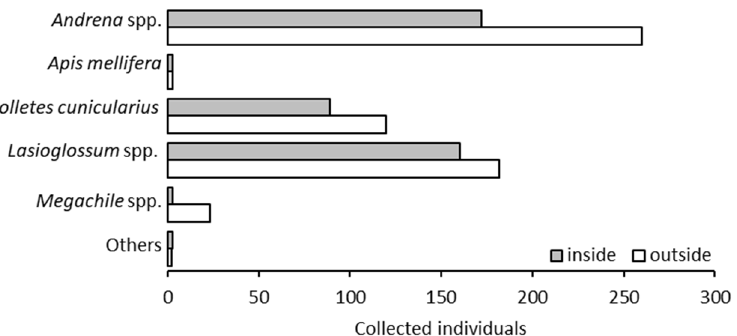
Figure 5. Abundance of different bee genera or species collected from 18 March to 5 April 2019 in coloured pan traps placed inside and outside a netted plot of apple trees before the hail net was closed (approximately 2 weeks before apple flowering